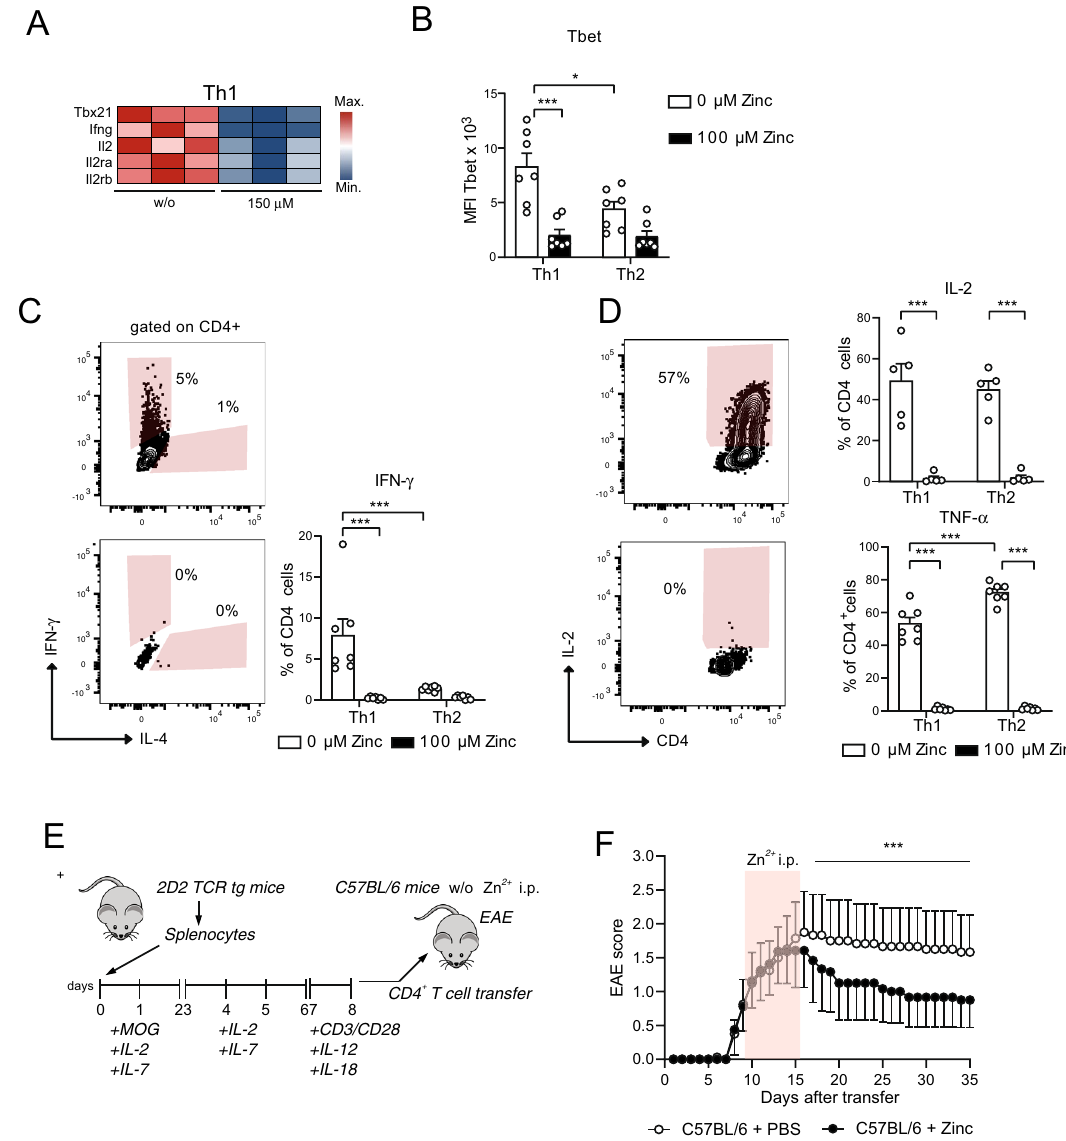
Figure 5. Zinc aspartate prevents Th1 CNS autoimmunity. ( A ) Heatmap showing Th1 genes of OT-II TCR tg CD4 + T cells in the absence and presence of 150 μM zinc aspartate. ( B ) MFI of Tbet measured by FACS of OT-II TCR tg CD4 + T cells differentiated into Th1 and Th2 cells in the absence and presence of 100 μM zinc aspartate. ( C ) Frequencies of CD4 + IFN-γ + cells measured by FACS after Th1 and Th2 differentiation in the absence and presence of 100 μM zinc aspartate. ( D ) Frequencies of CD4 + IL-2 + and CD4 + TNF-α + cells measured by FACS after Th1 and Th2 differentiation in the absence and presence of 100 μM zinc aspartate. ( E ) Splenic T cells of 2D2 mice were stimulated in vitro with MOG 35-55 in the presence of IL-2 and IL-7 and were reactivated with plate bound anti-CD3 and anti-CD28 in the presence of IL-12 and IL-18. Fully activated transgenic 2D2 T cells were adoptively transferred into C57BL/6 recipients. Zinc aspartate was administered daily i.p. (15 µg/animal) starting at day 8 after the appearance of first clinical signs. Zinc treatment was continued for 7 days. The control group received PBS. ( F ) The clinical score of passive EAE was assessed for 35 days after transfer. Data are shown as mean ± SEM. RNA sequencing data in ( A ) was generated in biological triplicates from 3 mice. Statistical analysis in ( B – D ) by unpaired student’s t test and in ( F ) by non-parametric Wilcoxon matched pairs test. Dots represent individual mice used to isolate OT-II TCR tg CD4 + T cells for Th differentiation. Data in ( B – D ) are from 3 experiments. Data in ( F ) are from 8 mice per group. *p < 0.05, **p < 0.01, ***p <